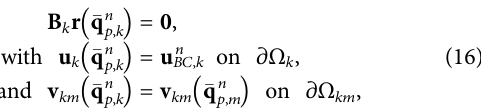
FIGURE 1 | An example of amulti-injector model rocket combustor with seven identical injector elements and the downstream combustor and nozzle